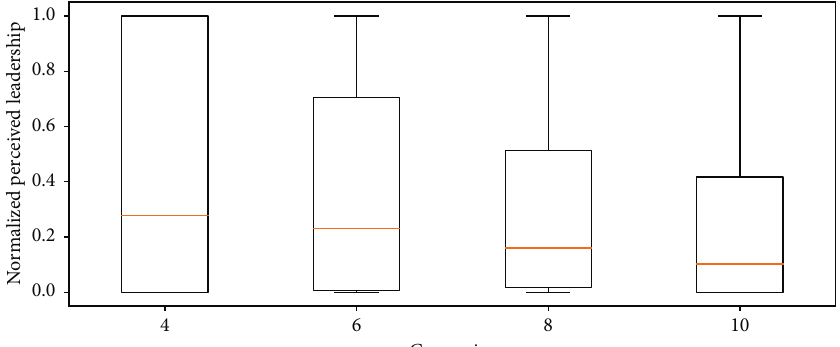
Figure 9: Distribution of normalized perceived leadership in different sized groups. Agent i ’s normalized perceived leadership after discussion is given by [ PL 300 i − min ( PL 300 leadership of agent i after 300 iterations and n is the size of